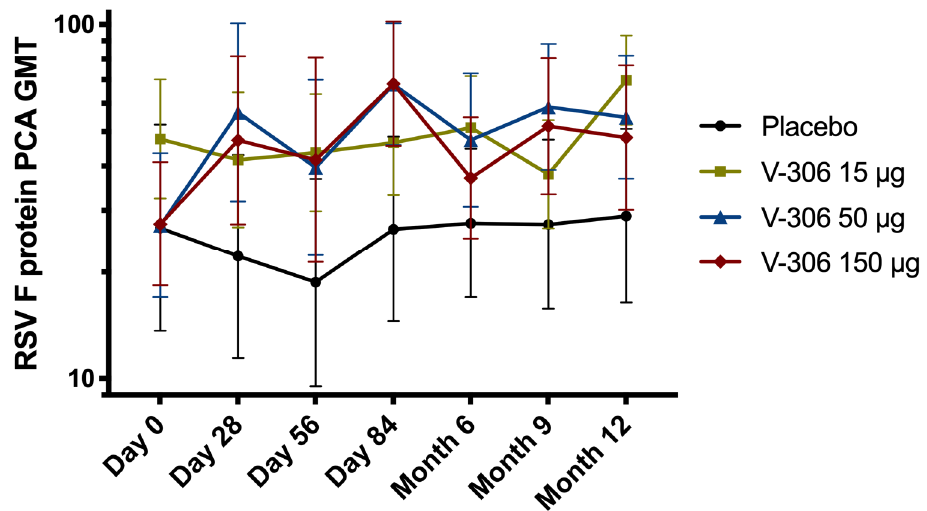
Figure 4. Evolution over time of serum antibodies geometric mean titers (GMTs ± 95% confidence interval [CI]) competing with palivizumab for binding to the RSV F protein antigenic site II (FsIIm) from baseline (Day 0 pre-vaccination) up to Month 12 (10 months after second administration) in the pooled placebo and three V-306 vaccine groups (15 µg, 50 µg, and 150 µg).